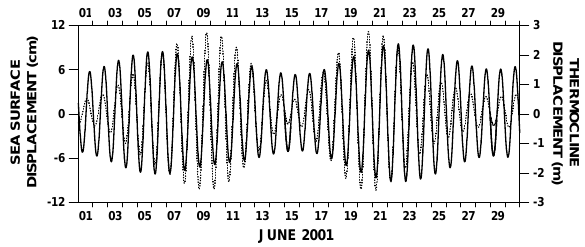
Figure 8. Sea surface displacement at Dubrovnik (full line) and thermocline displacement at Cape Struga (dotted line), filtered by a band-pass digital filter around diurnal period (June 2001).